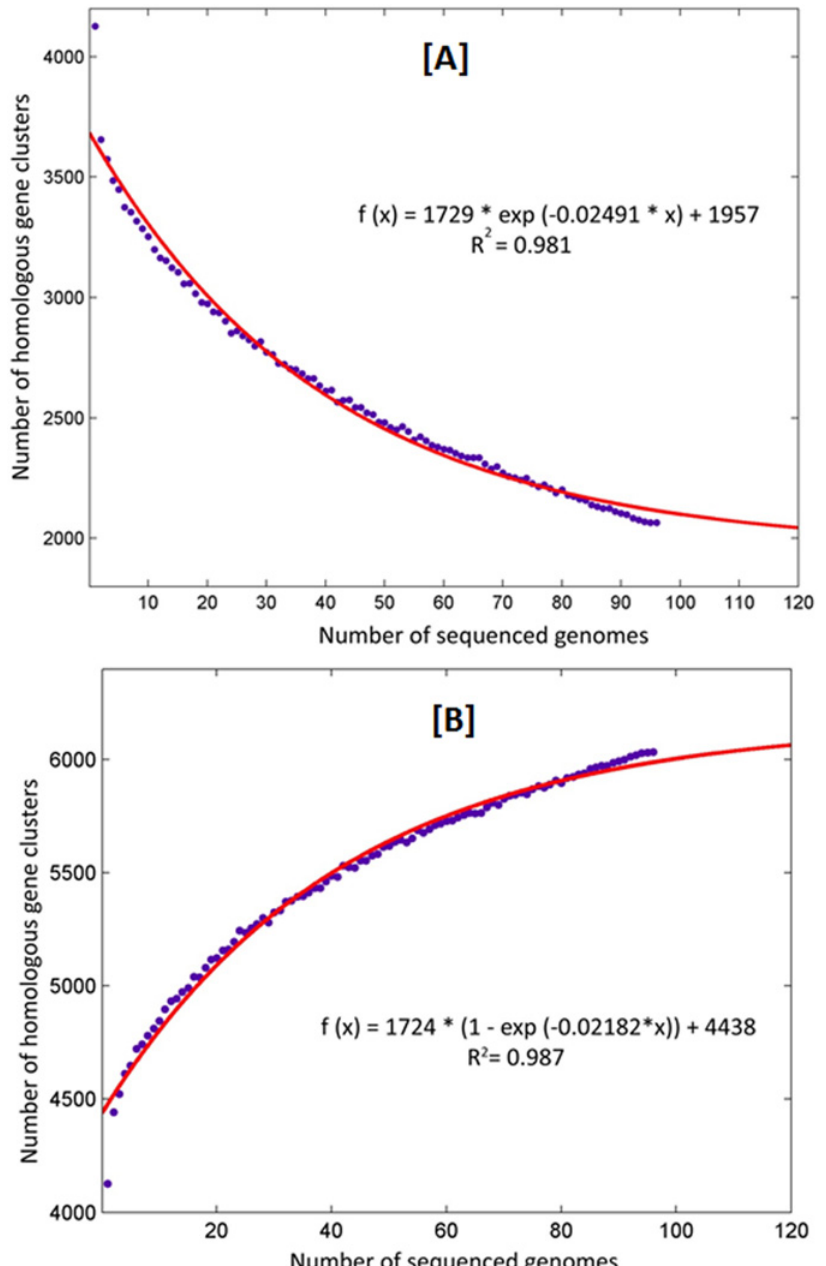
Fig 2. Core and accessory genome size evolution. (A) Each point indicates the number of HGCs conserved in a genome. The red line indicates an exponential decay function based on the median values of core HGCs when each time a new genome is added to the analysis. (B) Accessory genome of MTBC. The MTBC has an open pangenome model.